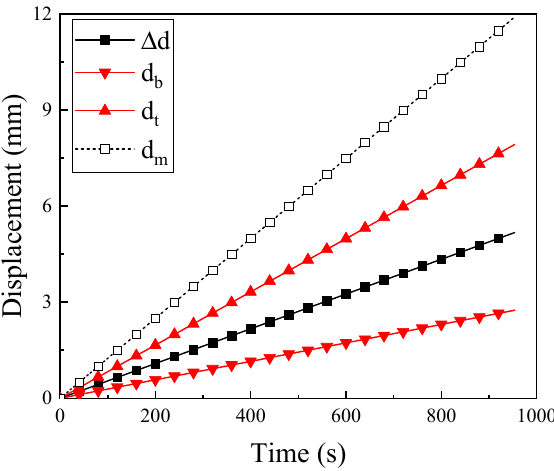
Figure 4. The typical results of displacement of testing machine and laser transducers.